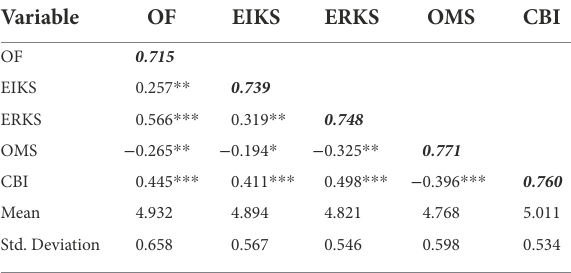
Table 6. The total effect of organizational forgetting on cross- TABLE 4 Mean, standard deviation, and correlations of